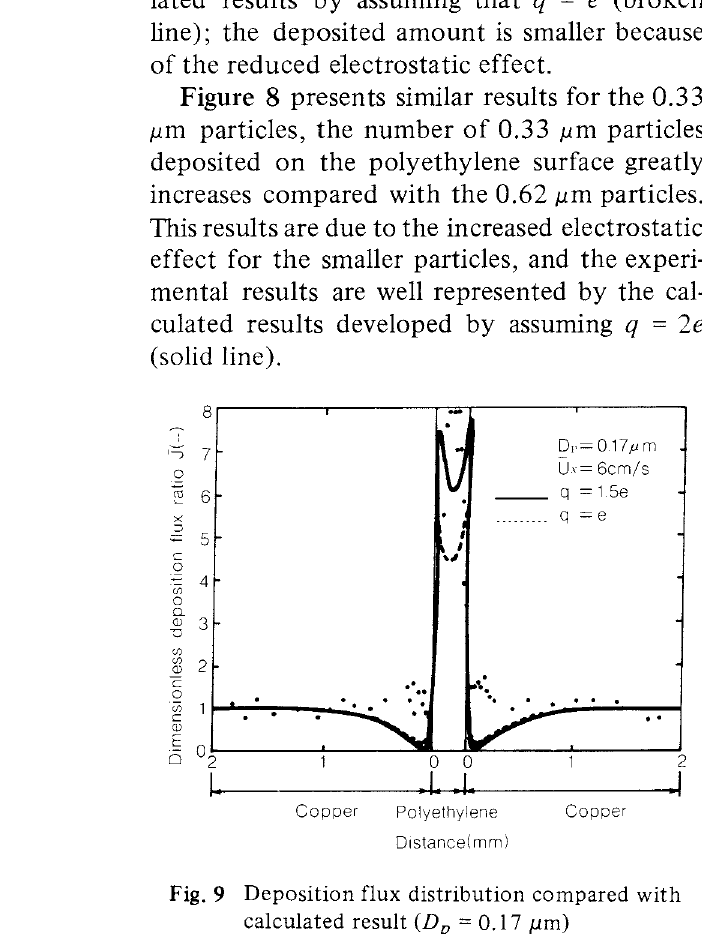
Fig. 9 Deposition flux distribution compared with calculated result (Dp = 0.17 pm)